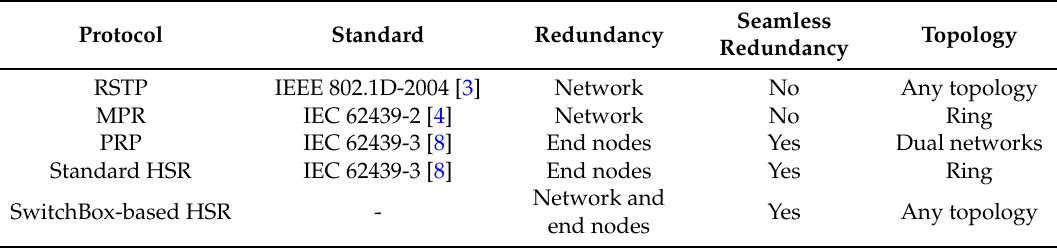
Table 6. Comparison of redundancy